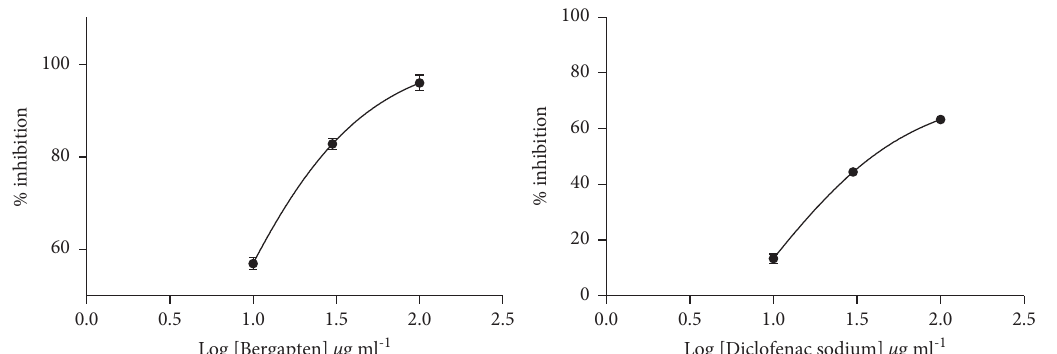
Figure 3: Dose-response curves for bergapten and diclofenac sodium in the egg albumin denaturation method. Data were presented as mean ±